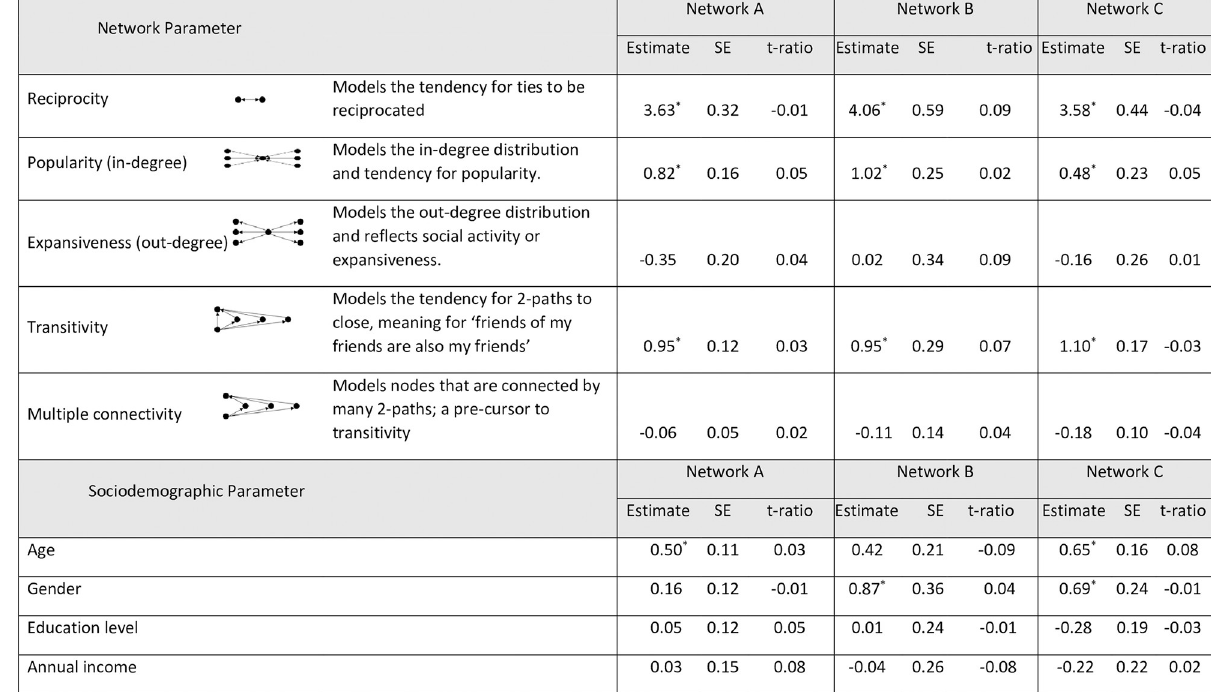
Fig 2. Effects of network structures and sociodemographic attributes on the church-based social networks by exponential random graph models (n = 281). Note: � Significant effect (i.e., parameter estimate is greater than two times the standard error in absolute value). SE; standard error. The parameter is the weight applied to the statistics (just as in a logistic regression with predictor variables and regression coefficient). An Exponential Random Graph Model (ERGM) assigns a probability to a graph by a sum of statistics weighed by parameters. For example, if the estimate of reciprocity parameter is large and positive, then graphs with many reciprocities are more probable in the graph distribution for that model. However, if the estimate of reciprocity parameter is large and negative, then graphs with fewer reciprocity become more probable under the model. Convergence of the estimation algorithm assessed by a t-ratio (parameter observation-sample mean/standard error): the absolute value should be < 0.1.